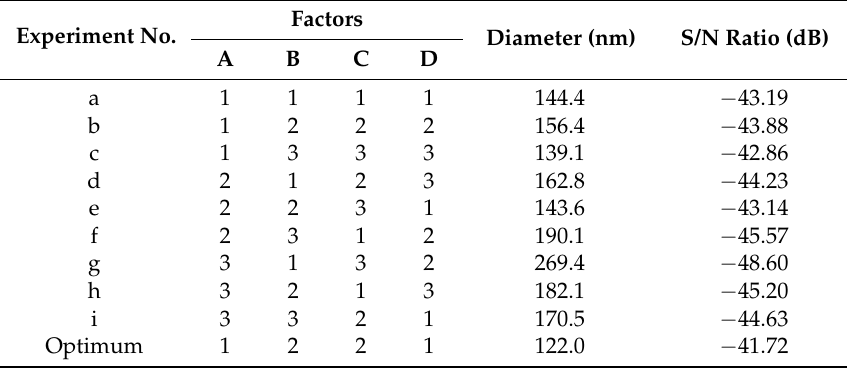
Table 4. L 9 orthogonal array design of experiment